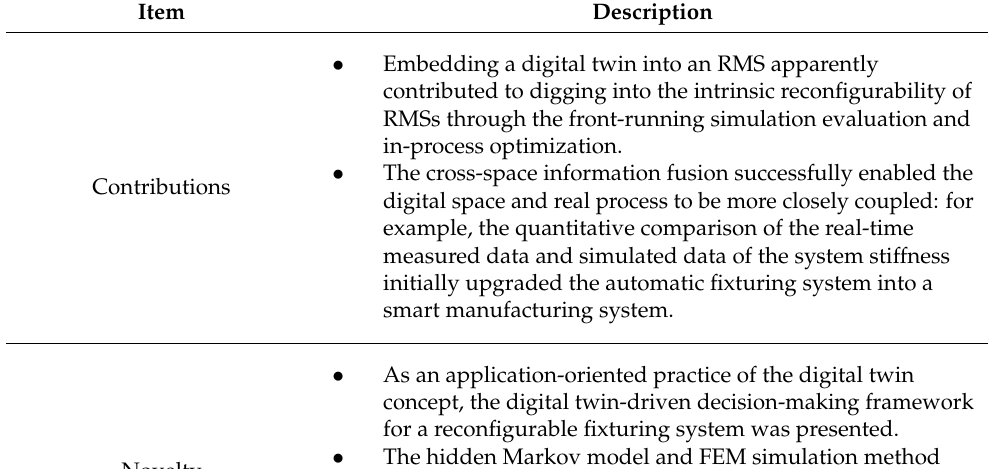
Table 3. Overview of digital twin-driven reconfigurable fixturing